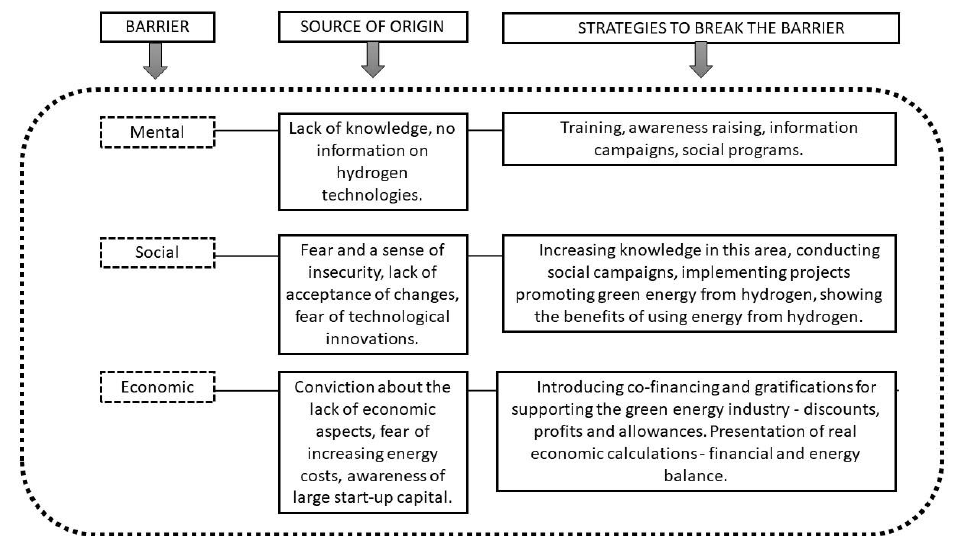
Figure 1. Barriers that arise when implementing modern (new, unknown) technologies—sources and methods (own study).